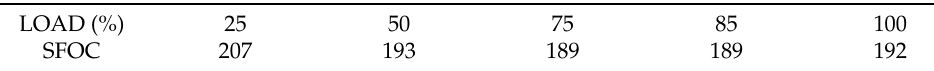
Table 3. SFOC values for aux. engines.